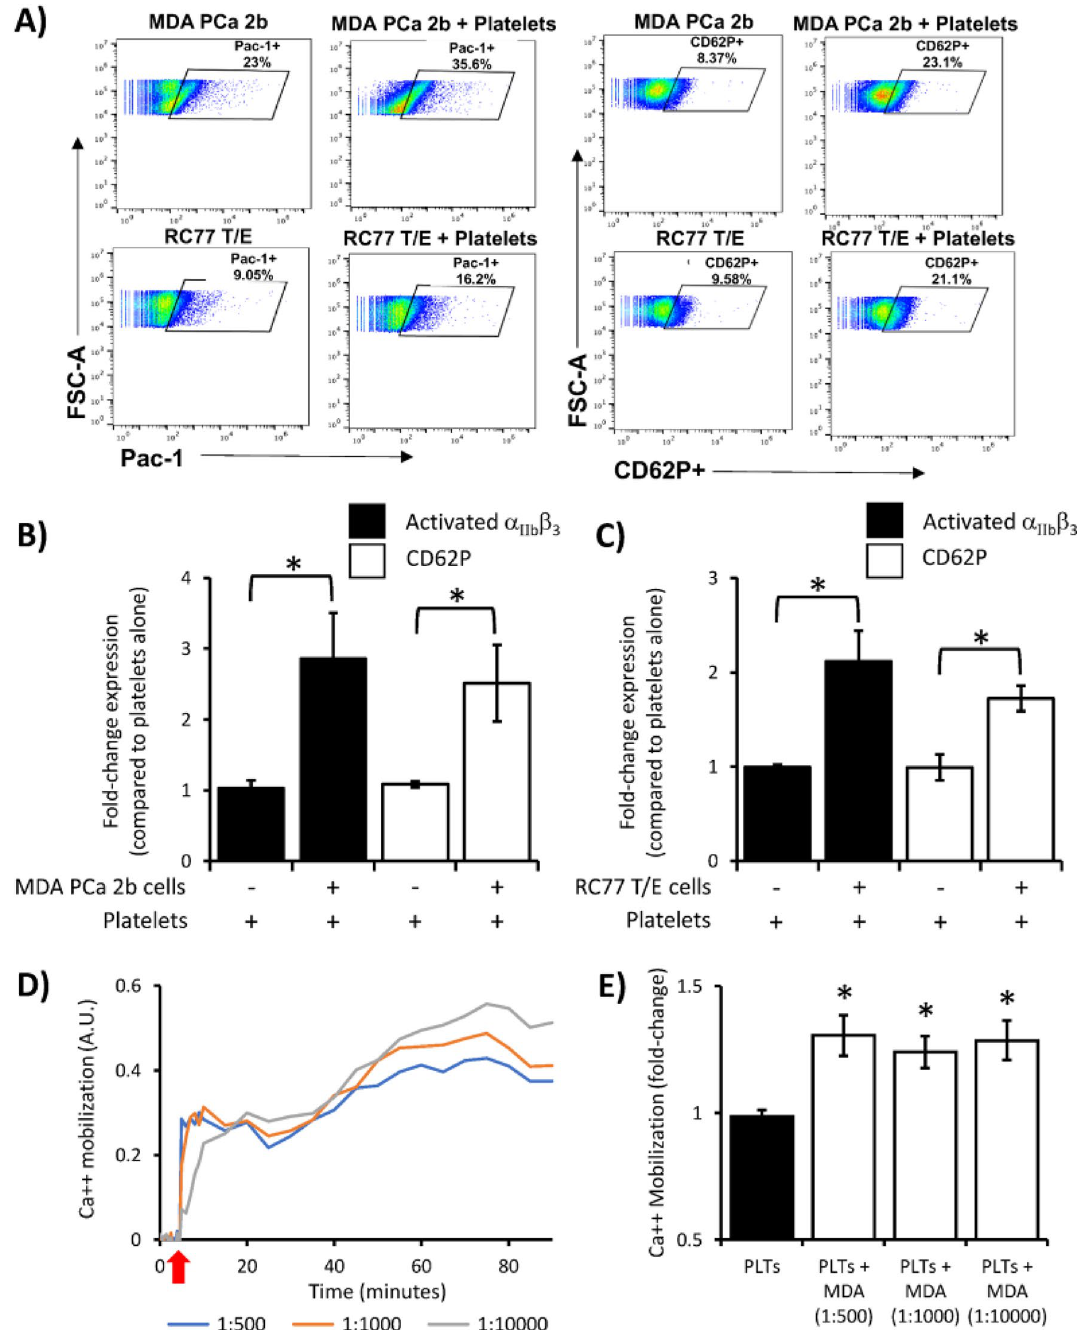
Figure 2. PCa cell lines MDA PCa 2b and RC77 T/E activate platelets. ( A ) Representative flow cytometry dot plots for surface expression of two platelet activation markers, activated integrin α IIb β 3 (PAC-1) and P-selectin (CD62P). Quantification of flow cytometry of platelets incubated with ( B ) MDA PCa 2b or ( C ) RC77 T/E cells for 24 h at a cell:platelet ratio of 1:1000. Data presented as the mean ± SEM of n = 5–6 independent determinations and analyzed by Student’s t -test, * P < 0.05. ( D ) Representative plot of calcium mobilization in platelets over 90 min following addition of MDA PCa 2b (MDA) cells at the indicated cell:platelet ratios. Red arrow indicates addition of MDA cells. A.U., arbitrary units. ( E ) Data presented as the mean ± SEM of n = 4–7 independent determinations at the indicated MDA cell:platelet (PLT) ratios and analyzed by ANOVA and Dunnett’s or Tukey’s post-hoc test, * P <